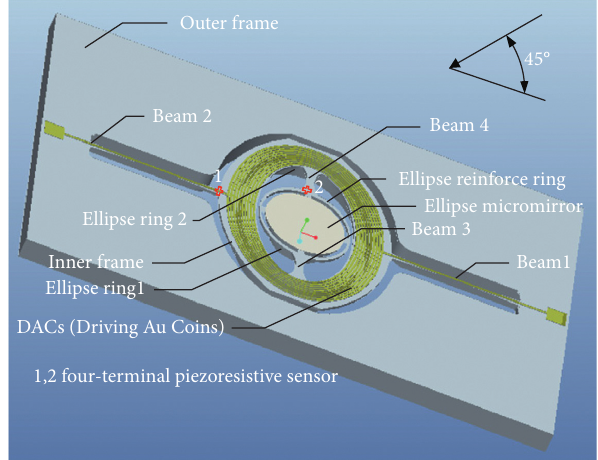
Figure 1: Structure of electromagnetic